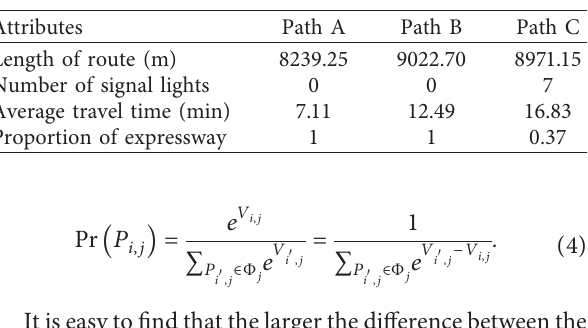
Figure 3: The sensor pair example. (a) The location of the sensor pair example and the GPS trajectories. (b) The distribution of travel Table 1: Attributes of path A and path B.